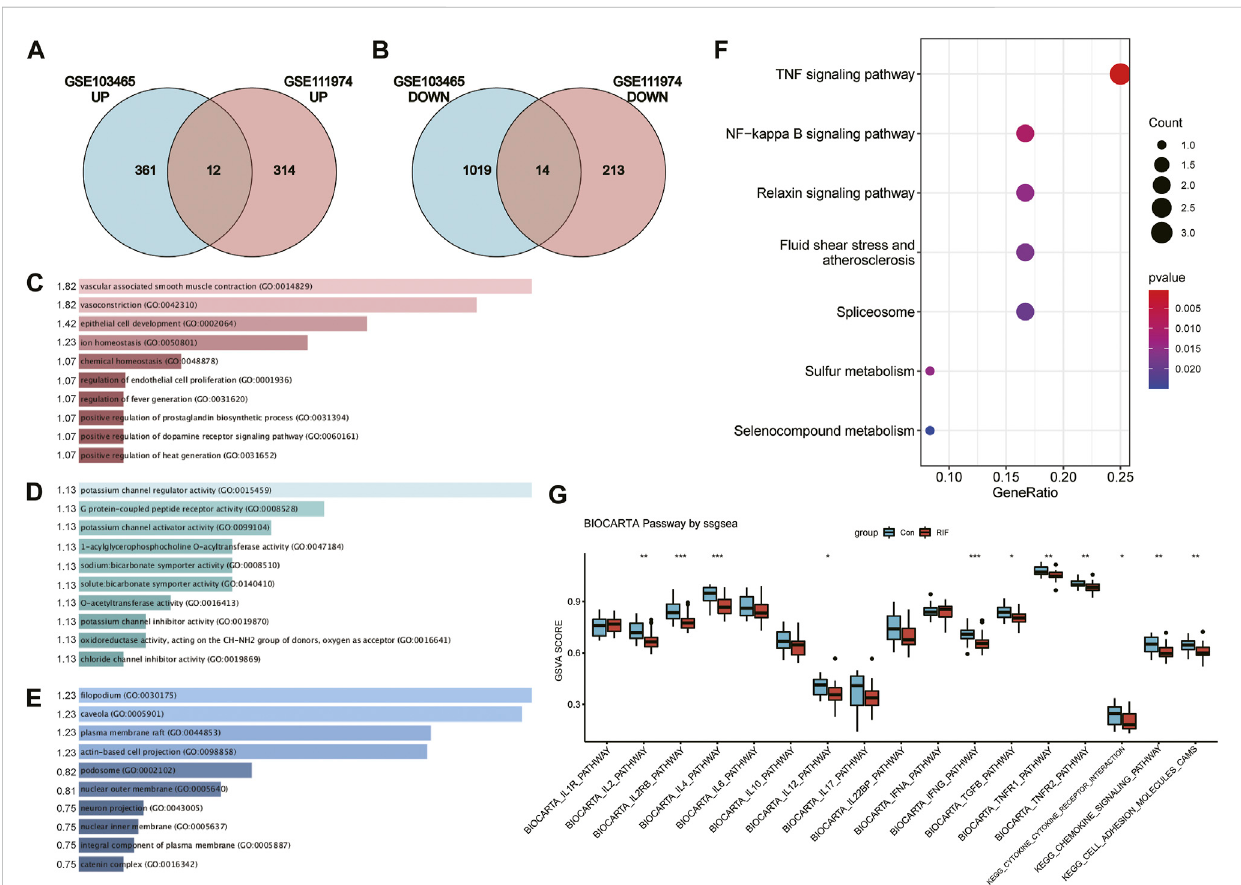
FIGURE 3 (A, B) Venn diagram of upregulated DEGs (A) and downregulated DEGs (B) from two datasets. (C – E) Bar graphs re fl ecting GO terms identi fi cation including Biological process (C) , molecular function (D) and cellular component (E) of common DEGs. The width represent the values of [ − log (Adjusted p -value)], which are listed beside the bars. (F) Bubble chart visualizing KEGG pathway analysis of common DEGs. (G) Box plot of BioCarta and KEGG pathway analysis via